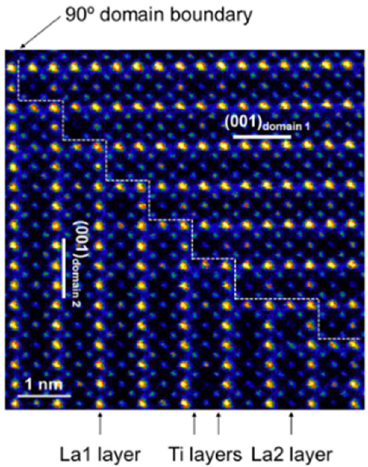
Figure 7. Schematic images of 90 ˚ domain boundary. Reprinted from [75], Copyright (2014), with permission from Elsevier.